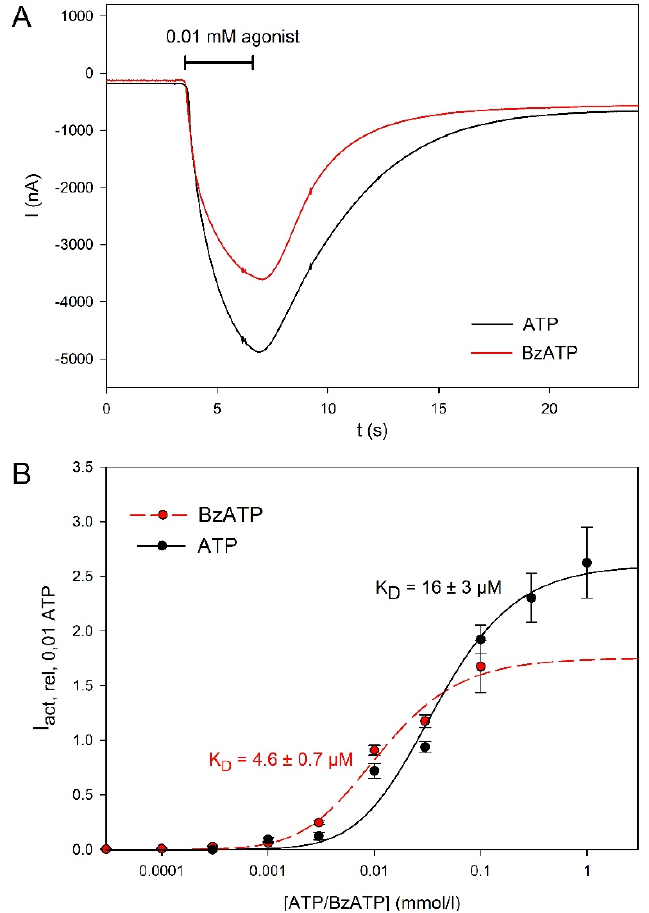
Figure 2. Agonist dependence of hP2X5 FL -mediated ion currents in X. leavis oocytes. ( A ) Examples of current traces elicited consecutively by ATP or BzATP as indicated in the same hP2X5 FL -expressing oocyte. ( B ) Concentration dependence of currents evoked by the indicated agonist. I act,rel,0.01ATP was calculated according to Equation (1) and the approximation was performed using Equation (2). Data are means ± SEM from of 4–12 oocytes.